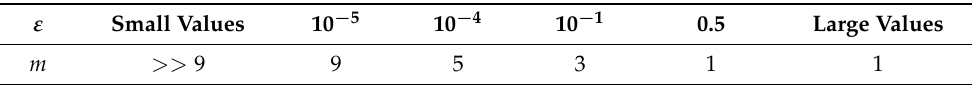
Table 4. Number of iterations based on the FPA and Condition (1) for various ε and t = 0.2, ρ = 1, ¯ h = −